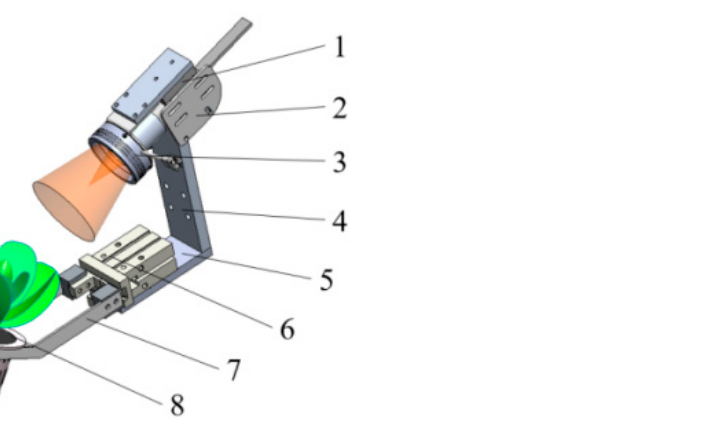
( c ) Figure 14. Single-claw transplanting actuator work plan. ( a ) Taking seedlings; ( b ) detection; ( c ) transplanting. According to the specifications of the seedling tray and the transplanting plate, a row of 3 seedlings can be transplanted on the transplanting plate at most. The center distance of the seedlings from grabbing to transplanting is increased from 72 mm to 180 mm. Therefore, the actuator should have the function of variable spacing, thus a three-claw transplanting actuator was designed, as shown in Figure 15. The structure and driving method of the clamping jaw are the same as those of the single-claw transplanting actua- tor. The guide rail is installed on the main board, and the timing belt and pulley are fixed on the guide rail. Two sets of sliding blocks are installed inside the guide rails in a sliding fit and are installed and fixed with the upper and lower sides of the synchronous belt, respectively. The middle jaw is fixed in the center of the main board, and the other two sets of jaws are respectively installed on the left and right sliders. The stepper motor is used to drive the synchronous belt to rotate, and the relative movement of the left and right sliders is realized.